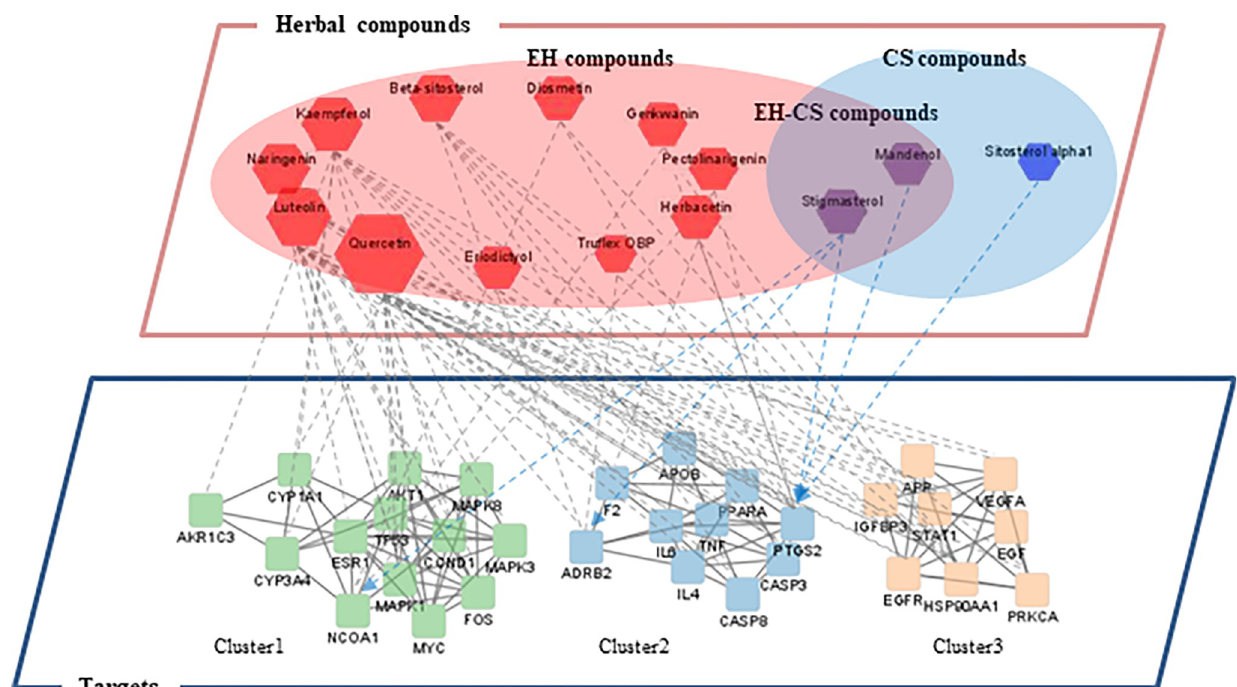
Fig 6. Visualization of the compound-target network of EH-CS. The upper layer represents herbal compounds from herbs and the lower layer represents networks of three modules (clusters) of 31 potential targets. Target clusters were created using kmeans clustering tools in STRING database.